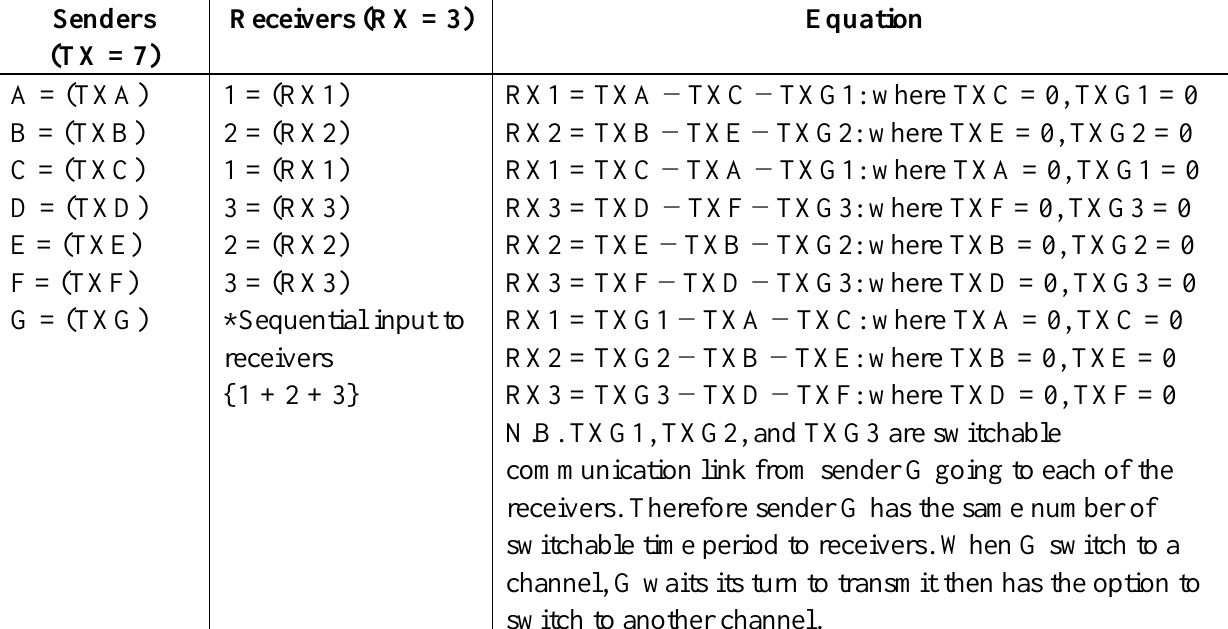
Table 3. Equation for uneven sender to multiple radios at sink node on 3 non-overlapping